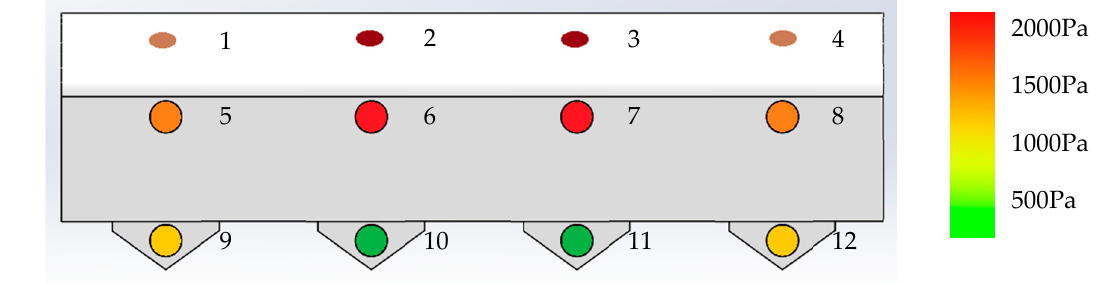
Figure 24. Pressure distribution of sensors at the bottom of skateboard.